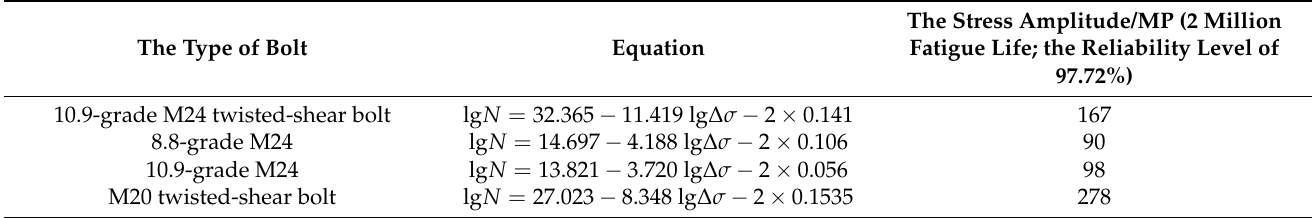
Table 16. Constant amplitude fatigue S-N curve equation of M24 and M20 high-strength bolts with large hexagon